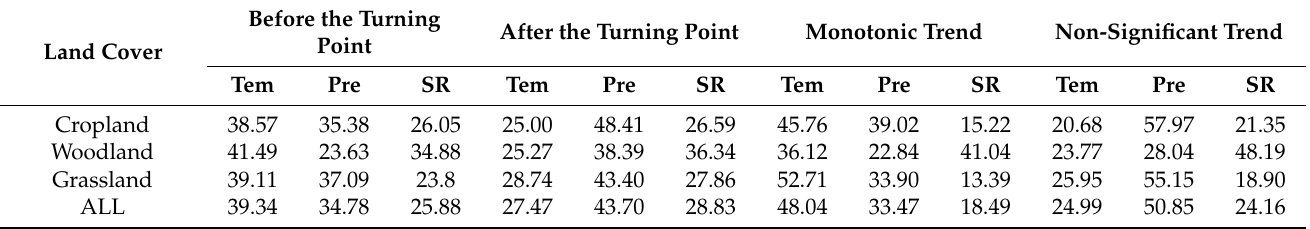
Table 5. Area percentage of vegetation controlled by different climate factors in different land cover types